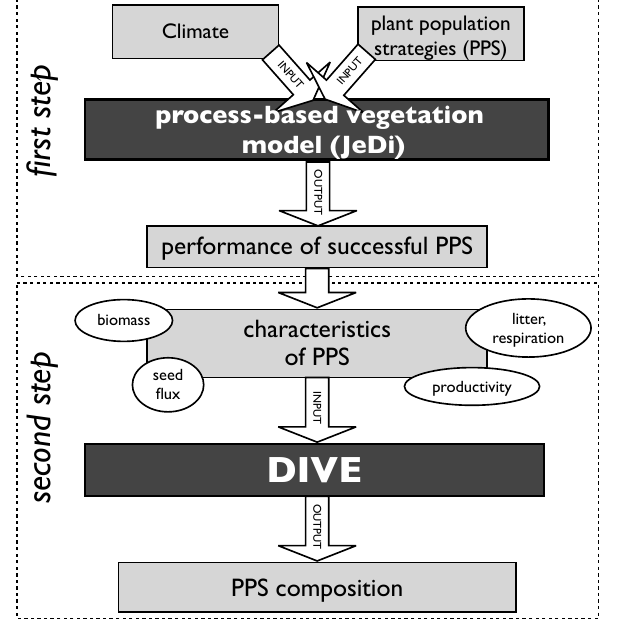
Fig. 1. Flow chart diagram of the model setup. First JeDi is run to produce the necessary input for DIVE (ellipses) to calculate popu- lation dynamics by competition.